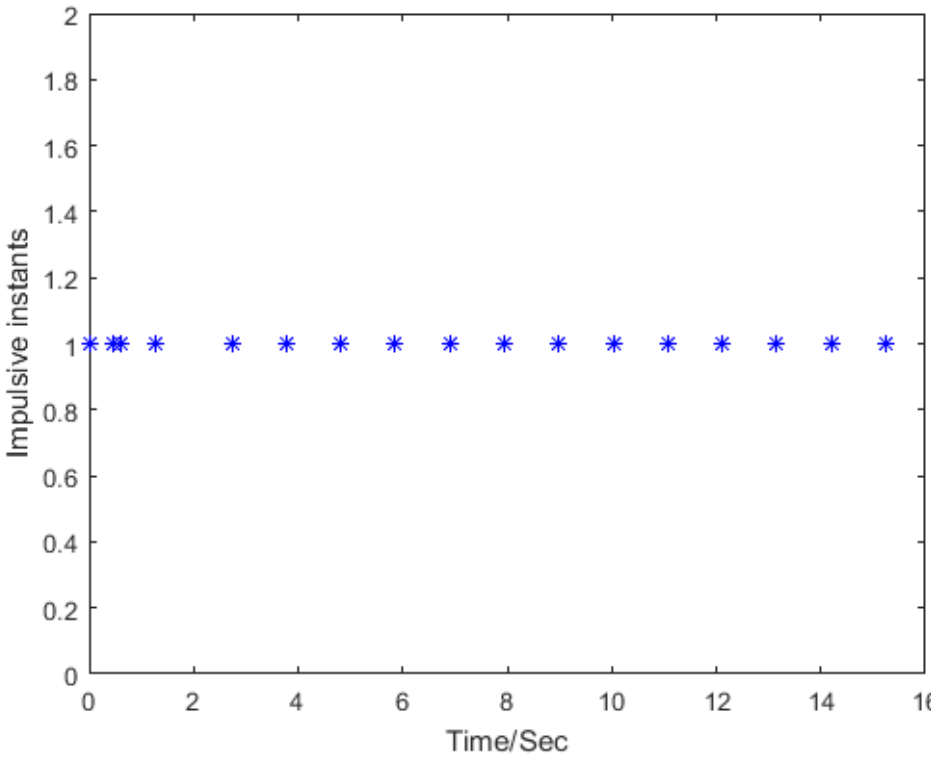
Figure 3. Impulsive instants with τ = 0.1.